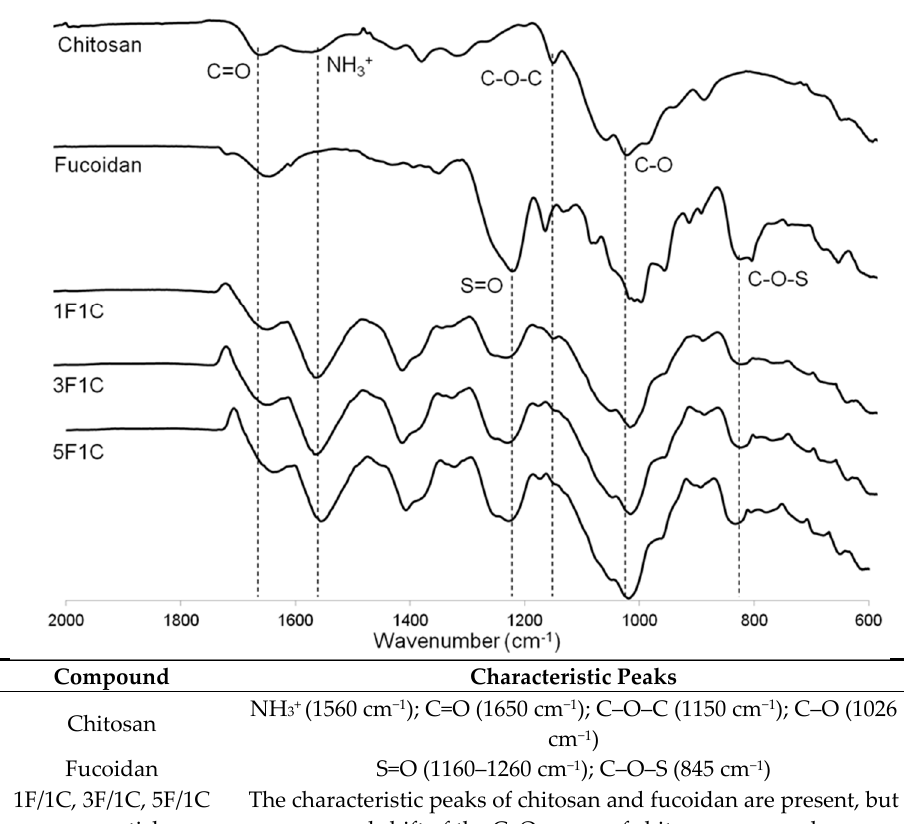
Figure 1. Fourier-transform infrared (FTIR) spectra of chitosan (C), fucoidan (F), and 1F/1C, 3F/1C, and 5F/1C nanoparticles, as well as a list of the characteristic peaks of each compound and produced nanoparticles.